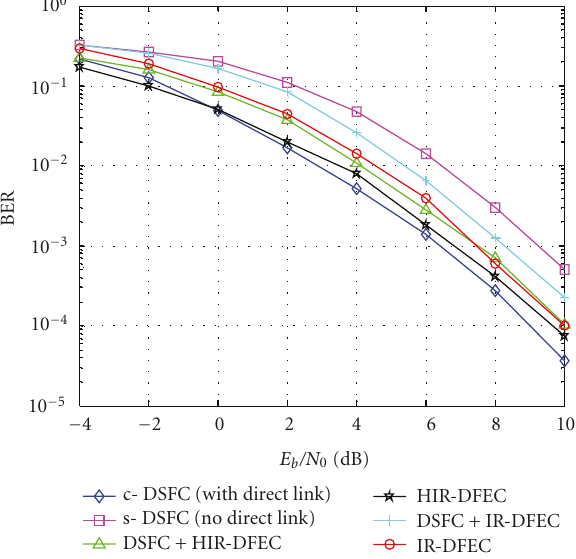
Figure 7: BER versus E b /N 0-directlink ; DSFC, DFEC, and DSFC+DFEC algorithms—scenario U1.